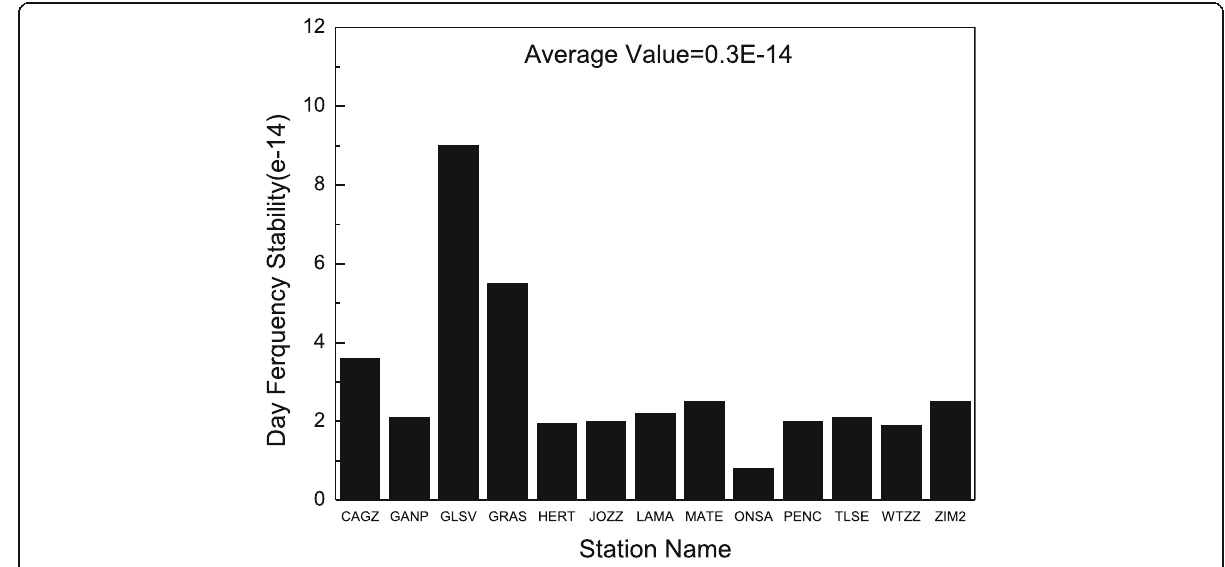
Fig. 11 Frequency stability index of the time difference sequence of different